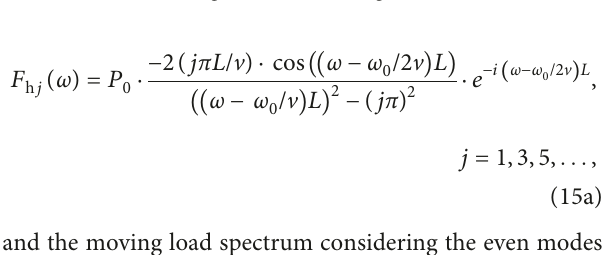
Figure 2: Bridge under a moving harmonic